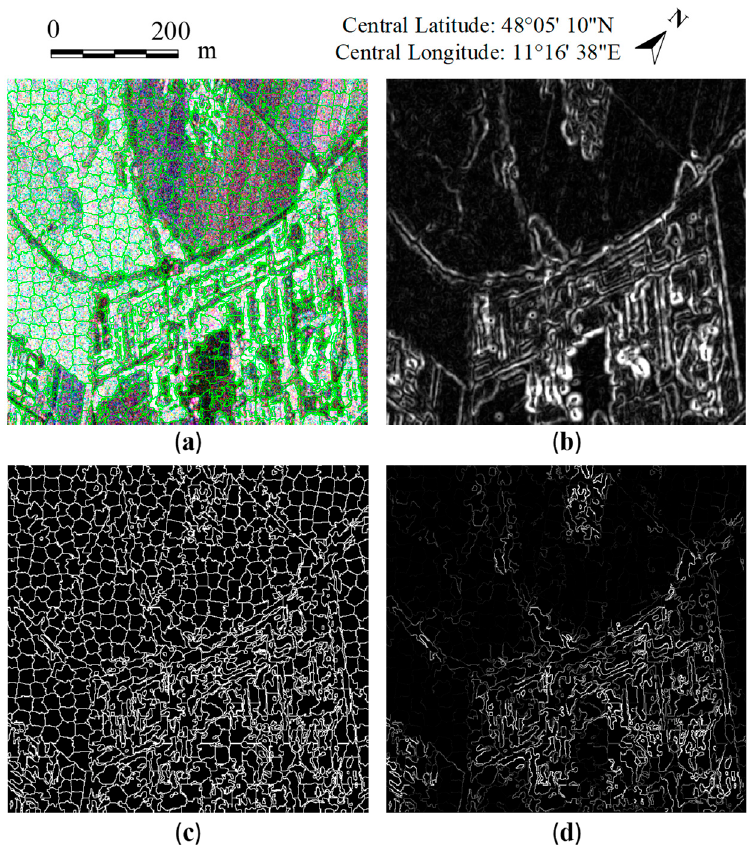
Figure 2. Representation of the edge penalty on real Polarimetric SAR (PolSAR) data: ( a ) Pauli RGB image (red channel describes double-bounce scattering, green channel describes volume scattering, and blue channel describes single-bounce scattering); ( b ) Edge detection result; ( c ) Boundaries of superpixels; ( d ) The edge penalty map with the boundary value set as the edge penalty between neighboring superpixels.